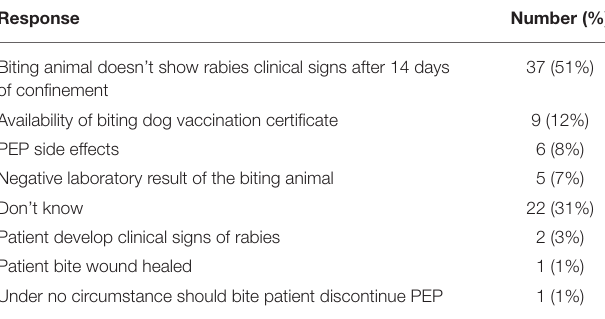
TABLE 2 | Responses on circumstance under which PEP should be discontinued. Response